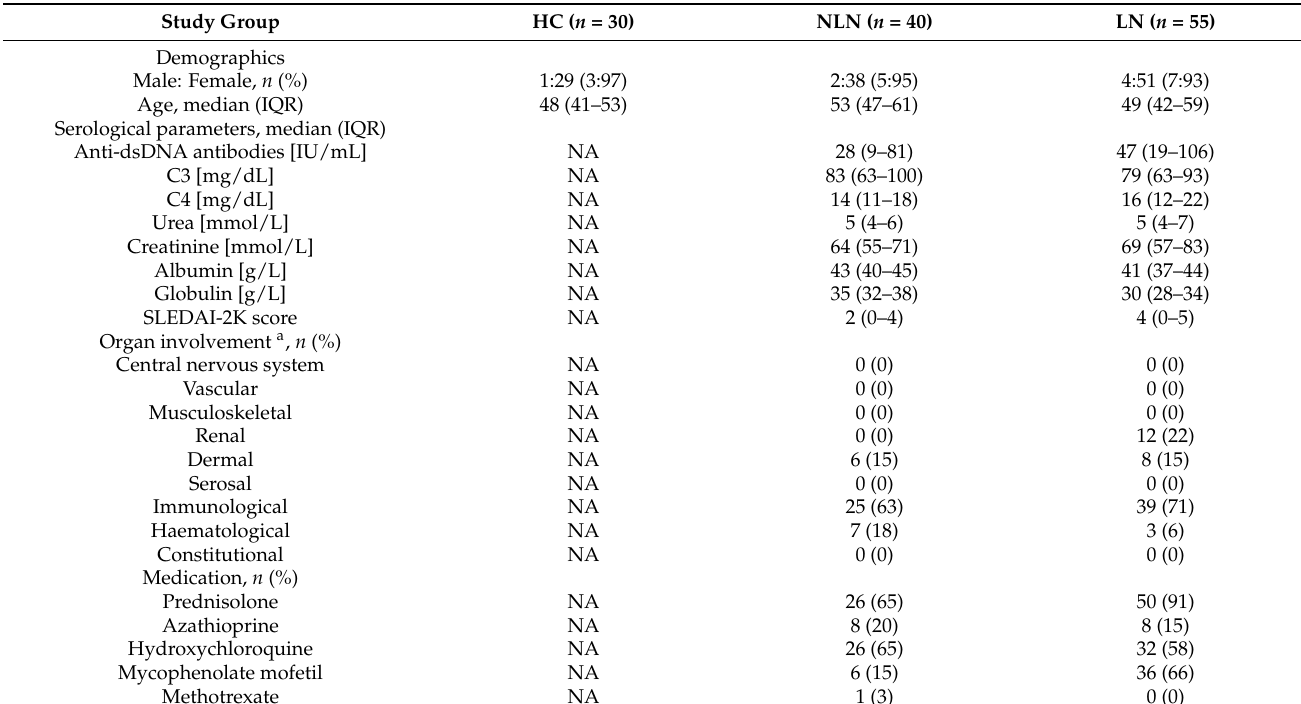
Figure 1. Elevated expression of IL18RAP in neutrophils from SLE patients. ( A ) qRT-PCR analysis on IL18RAP expression in neutrophils from healthy controls (HC, n = 30) and SLE patients ( n = 95). RQ, relative quantity; **** p < 0.0001 by Mann–Whitney U test. ( B ) Western blotting on protein expression of IL18RAP in neutrophils was performed using an independent set of samples. Representative blot of three independent experiments showing four samples in HC and SLE patients. Arrows indicate the position of molecular weight markers. ( C ) Summary chat showing relative IL18RAP protein expression in neutrophils between HC ( n = 11) and SLE patients ( n = 11), as measured by normalized densitometry signal intensity. A.U., arbitrary unit; * p < 0.05 by Mann–Whitney U test. Data were shown as the median (horizontal line) with interquartile range (IQR, box), lower and upper whiskers (data within 1.5 × IQR), and outliers (points) (Tukey’s box). Table 1. Demographics and clinical characteristics of study